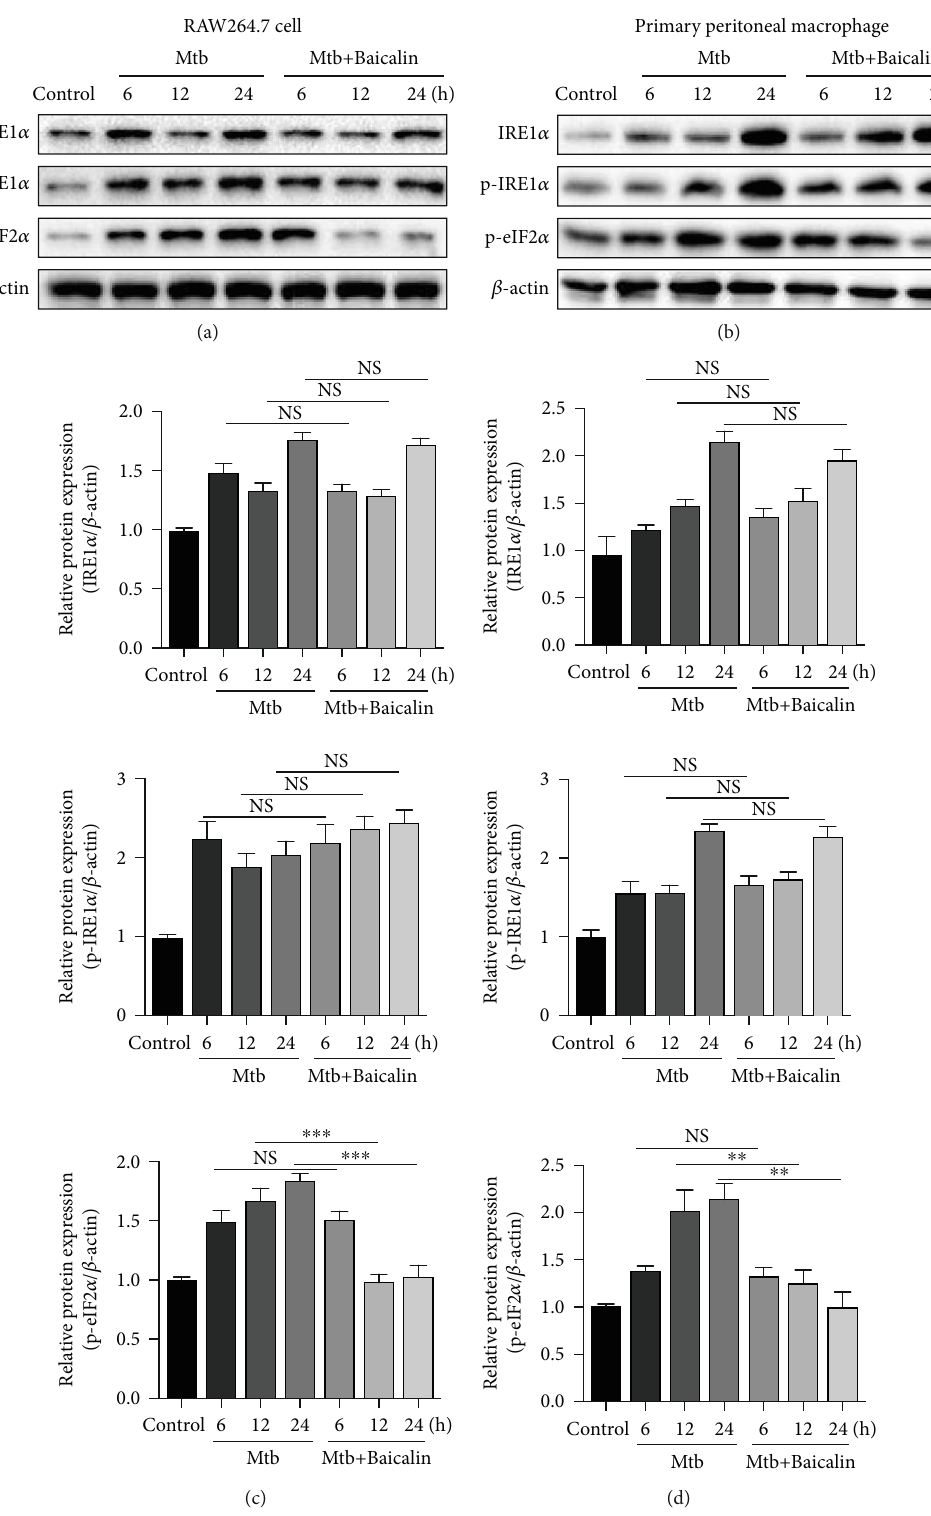
Figure 5: Baicalin inhibits endoplasmic reticulum stress in Mtb-infected macrophages. (a, c) Western blotting analysis of IRE1 α , p-IRE1 α , and p-eIF2 α expression in RAW264.7 cells. (b, d) Levels of IRE1 α , p-IRE1 α , and p-eIF2 α protein assessed by western blotting in primary peritoneal macrophage cells. Data are shown as mean ± SD of at least three independent experiments. ∗∗ p < 0 : 01 ; ∗∗∗ p < 0 : 001 ; NS: nonsigni fi